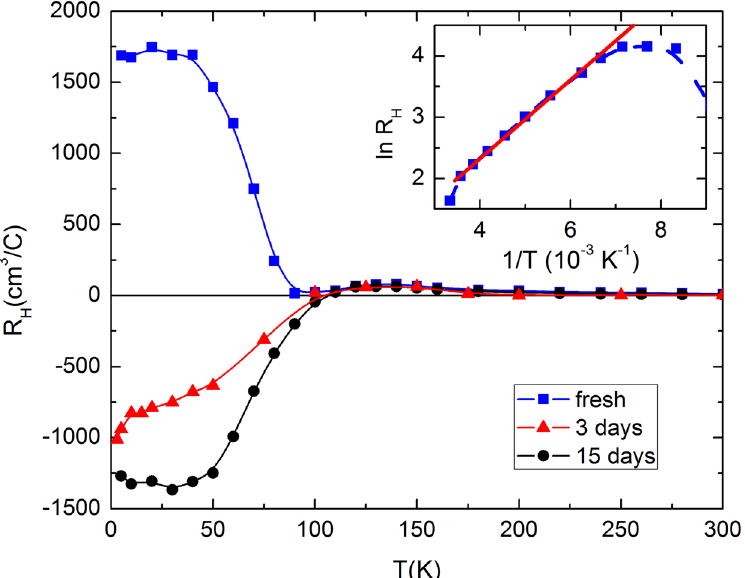
Figure 3. Temperature dependence of the low-field Hall coefficient ( R H ) for Bi 1.5 Sb 0.5 Te 1.7 Se 1.3 single crystal (S2) at different ages. The blue squares are the R H data for the freshly cleaved S2 crystal. The red triangle and black solid circle represent R H data for the same S2 sample after being exposed to air for 3 days and 15 days, respectively. Inset shows ln( R H ) vs 1/ T plot for freshly cleaved S2 crystal. The solid line shows the linear behavior of ln( R H ) at high temperatures above 160